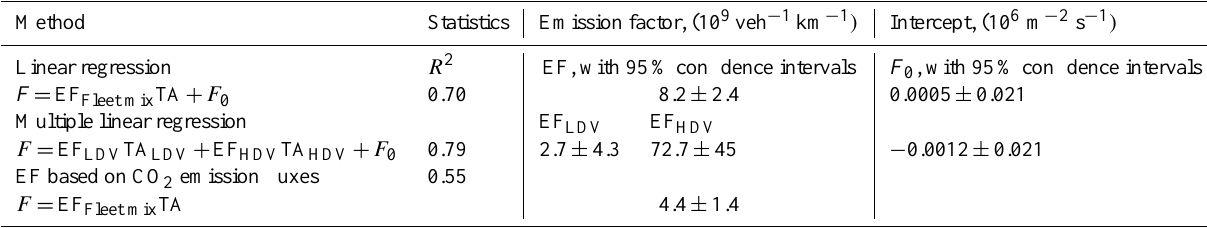
Table 3. Comparison between the different attempts to find a source parameterisation ( F ) for aerosol particles larger than 0.8µm D p . The traffic activity used is the mean daily traffic activity from (Monday-Friday, 24 values) in the NE sector over an area of 1km × 1km, (TA, traffic activity, LDV, light duty vehicles and HDV, heavy-duty